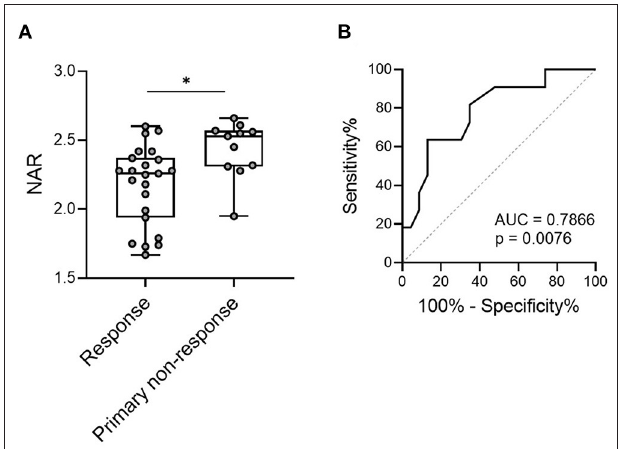
FIGURE 4 | NAR predicts short-term response to infliximab (IFX) in patients with UC. Patients with UC ( n = 34) were infused with IFX (5 mg/kg) at weeks 0, 2 and 6 for induction. Short-term response to IFX were evaluated at 12–14 weeks post initial infusion. Patients were subjected to complete blood cell and serum biochemistry tests within 1 week before the first infusion of IFX, and pre-treatment NAR was calculated. (A) Comparison of pre-treatment NAR was performed between responders (complete and partial, n = 23) and primary non-responders ( n = 11). * p < 0.05, unpaired Student’s t -test (two-tailed). (B) The ability of NAR to discriminate IFX responders from primary non-responders were determined by ROC curve analysis. p < 0.05 was considered significant.